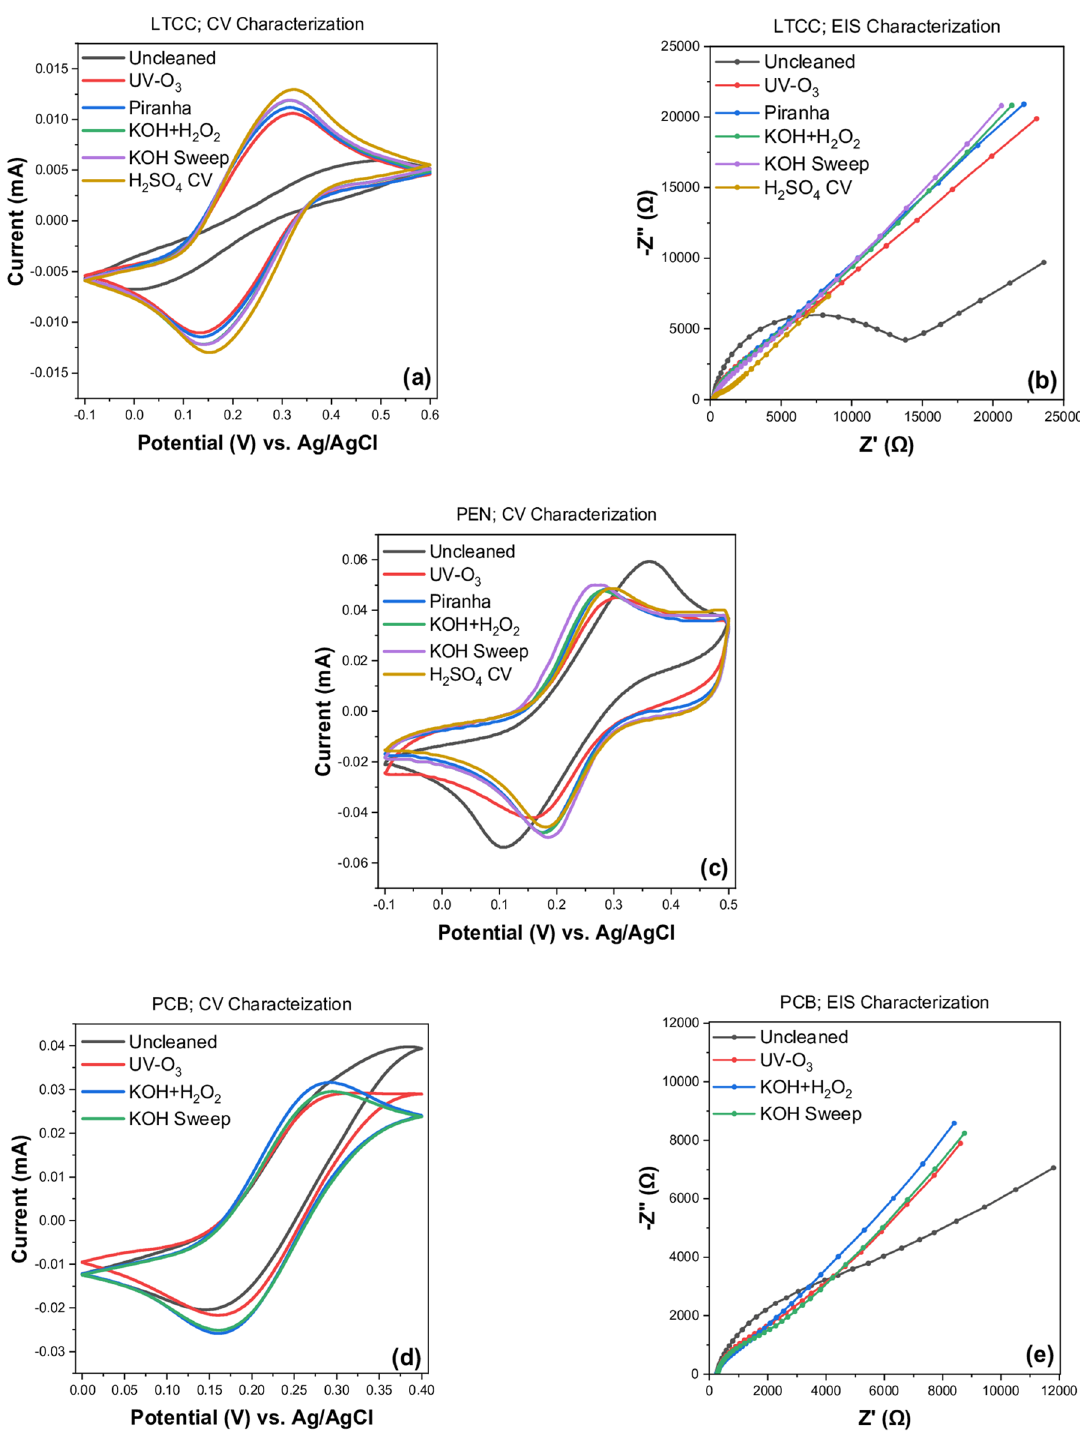
Figure 2. Electrochemical analysis of LTCC, PEN, and PCB sensor surfaces in PBS + 1 mM [Fe (CN) 6 ] 3−/4− before and after each cleaning procedure. Cyclic voltammograms of ( a ) LTCC, ( c ) PEN, and ( d ) PCB sensors at 20 mV/s scan rate. Impedance curves of ( b ) LTCC and ( e ) PCB at amplitude of 10 mV within the frequency range of 0.1–100 kHz. KOH Sweep is the abbreviation of KOH + H 2 O 2 /KOH